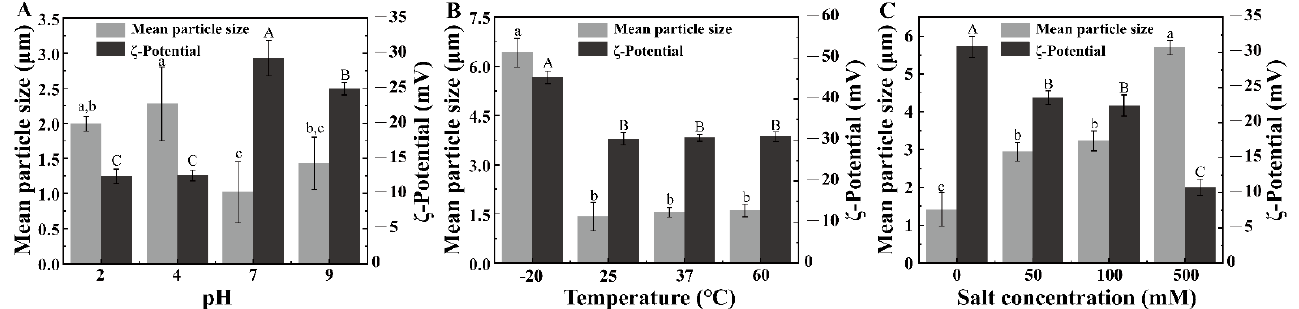
Figure 1. Mean particle size and ζ -potential of the Pickering emulsion under different environmental stresses. ( A ) pH, ( B ) temperature, and ( C ) salt concentration. Different letters indicate significant differences ( p < 0.05).